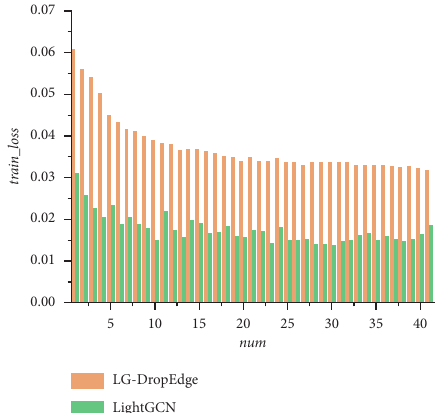
Figure 4: Train_loss comparison at the same ndcg level (Amazon-